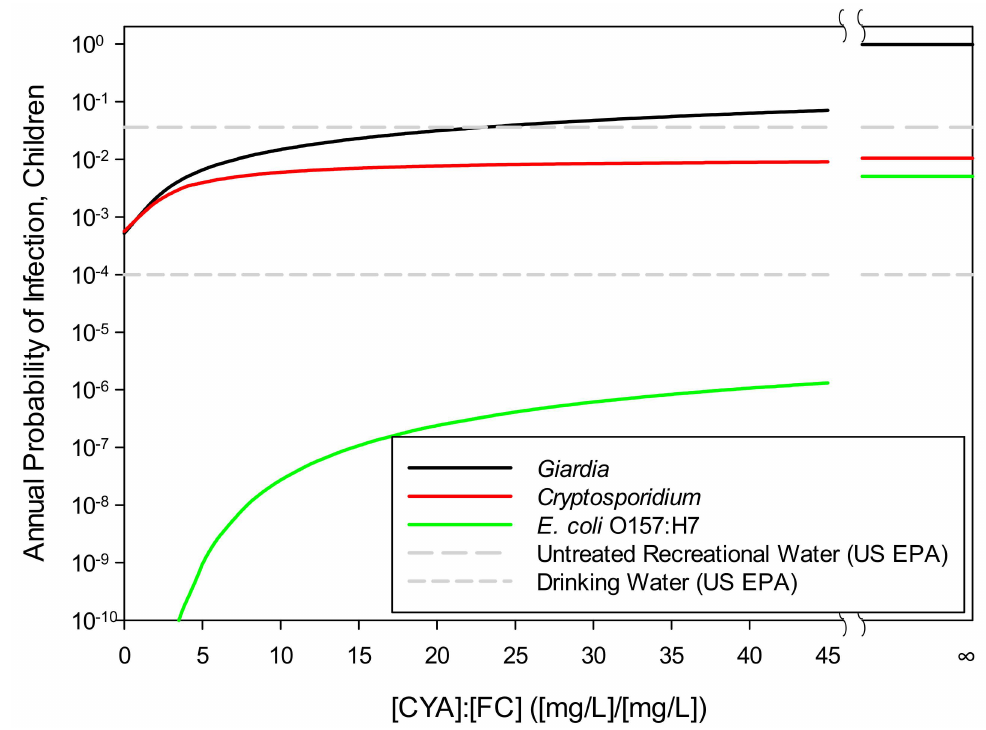
Figure 7. Annual probability of infection with Giardia , E. coli O157:H7, or Cryptosporidium parvum as a function of CYA / FC: For calculation purposes, FC was 2 mg / L for all points except CYA / FC = ∞ , for which FC was set at zero. The U.S. EPA limits for drinking water (10 − 4 , U.S. EPA [66]) and beaches (36 / 1,000, U.S. EPA [67]) are included for reference.